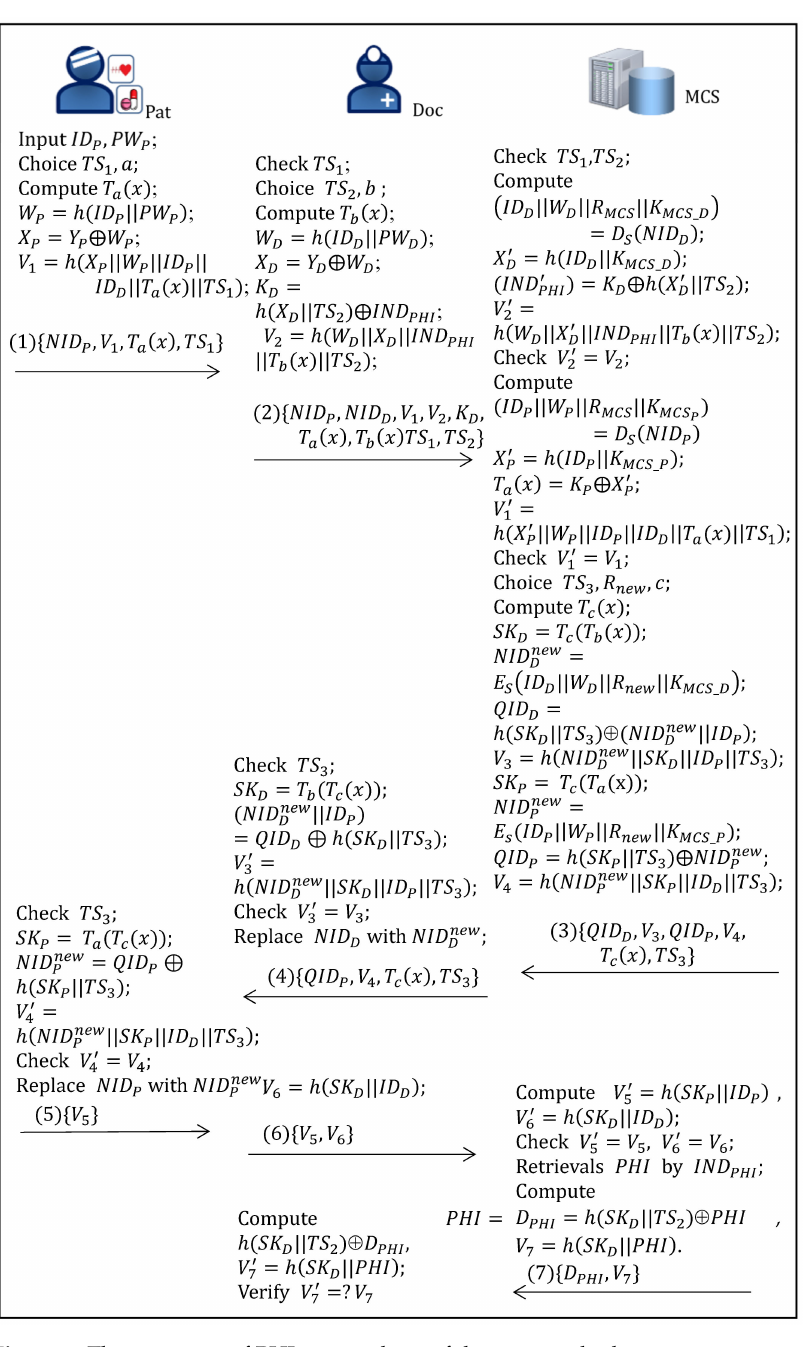
Figure 2. The processes of PHI access phase of the proposed